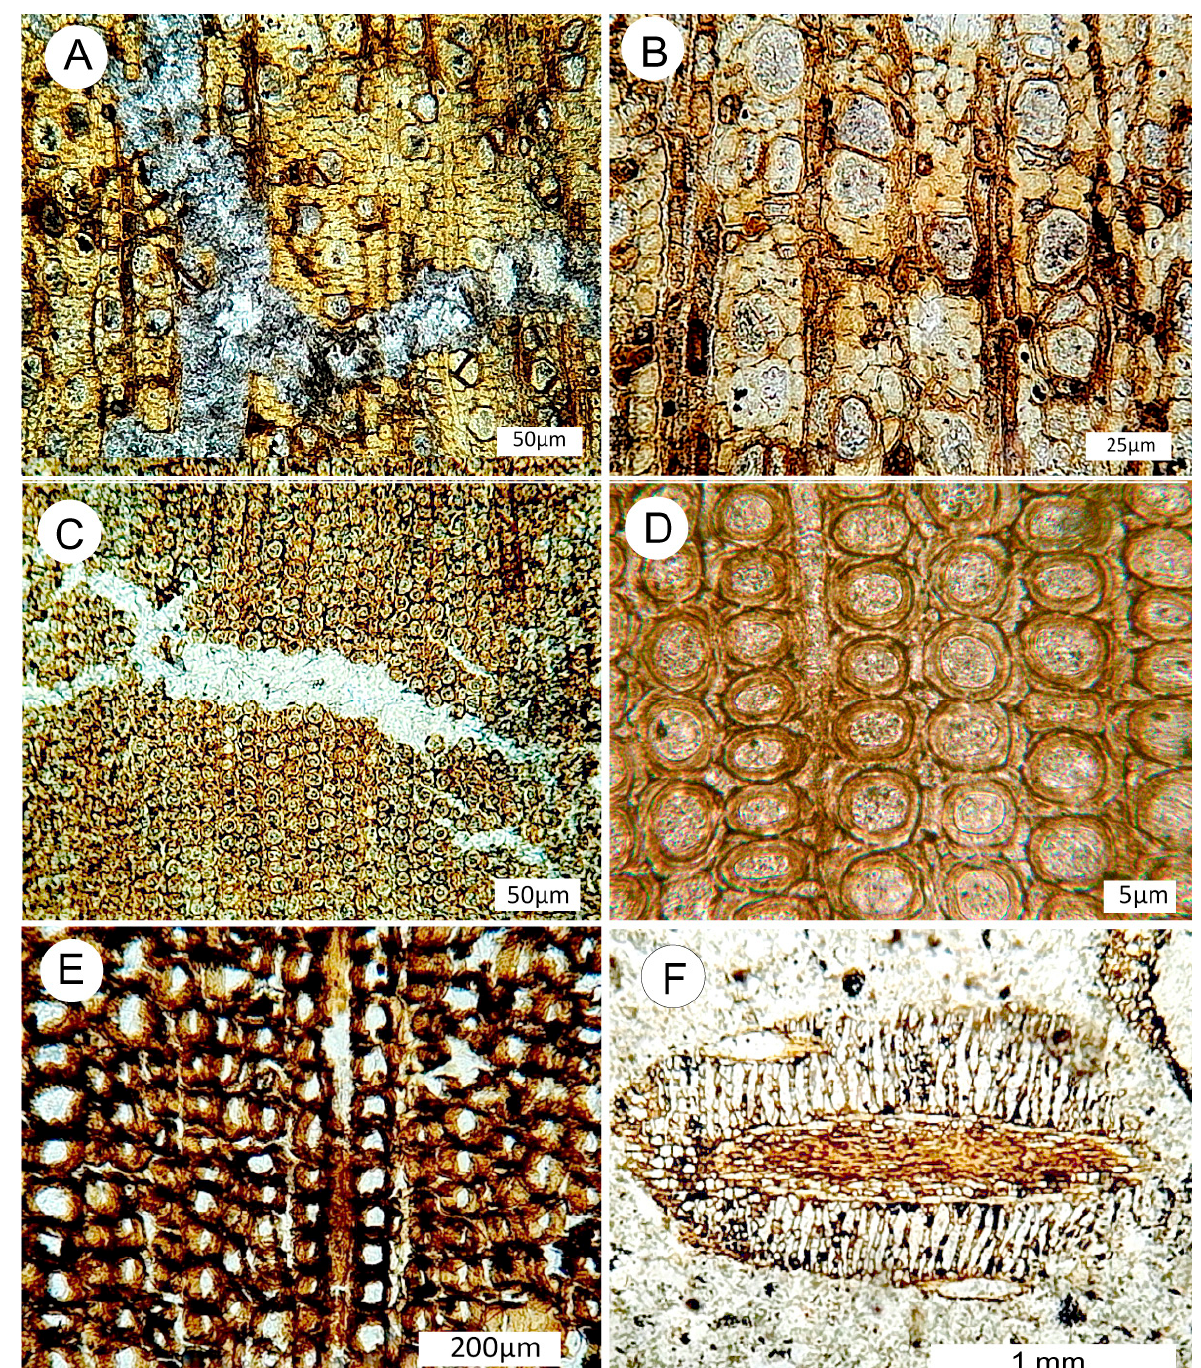
Figure 5. Optical photomicrographs of Nanaimo Island calcite-mineralized wood. ( A , B ) Thin section views of Upper Cretaceous wood from Collishaw Point, Hornby Island. ( A ) Transverse view showing prominent calcite vein. ( B ) Transverse view showing brown cell walls and lighter colored lumen. ( C , D ) Thin section views of Upper Cretaceous conifer wood from Puntledge River locality. ( C ) Transverse view showing calcite vein. ( D ) Transverse view showing thick cell walls and calcite-filled lumen. ( E , F ) Acetate peels of Lower Cretaceous conifer wood from Apple Bay. ( E ) Transverse view showing cell walls preserving relict organic matter. ( F ) Oblique transverse view of conifer leaf, showing central vascular bundle surrounded by mesophyll cells.